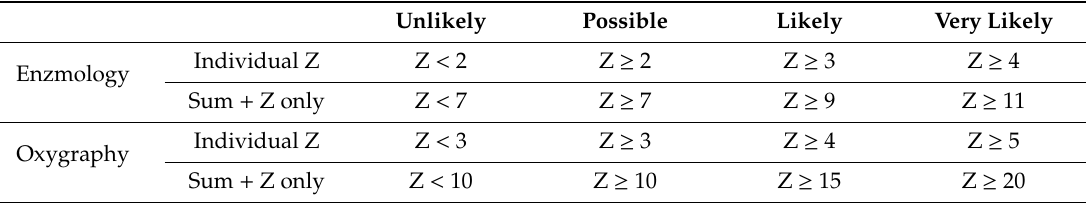
Table 5. Diagnostic prediction Z score